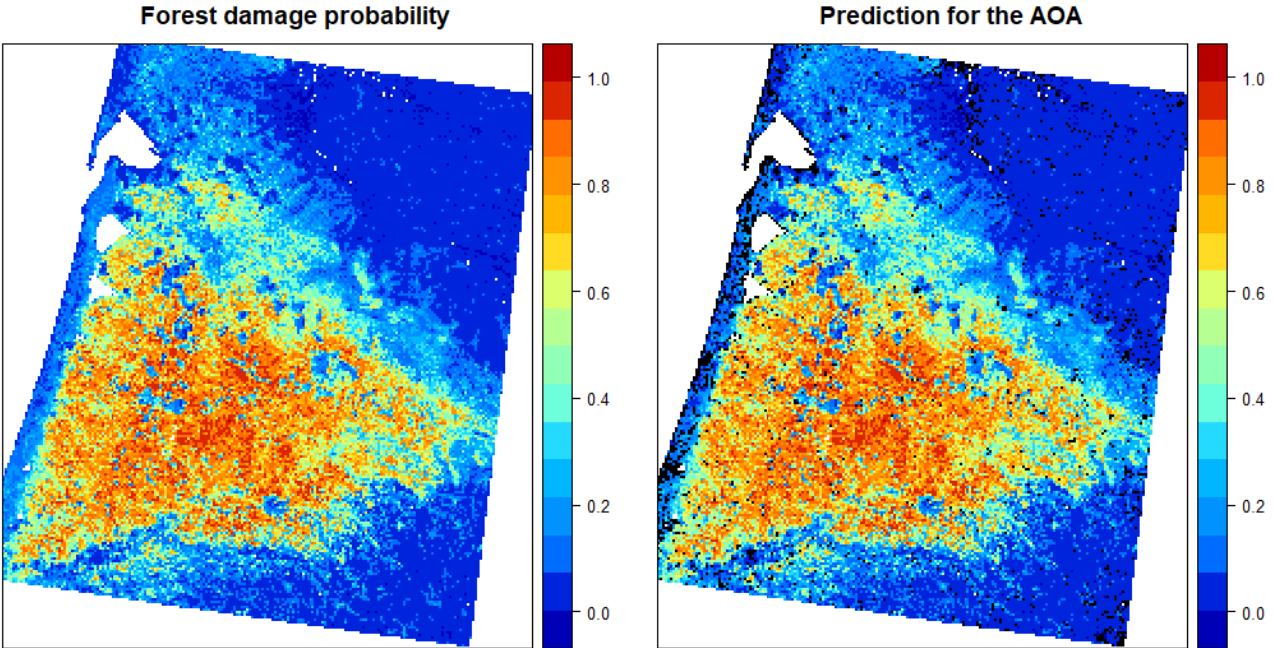
Figure 6. Map of forest damage probability and prediction of the Area of Applicability (AOA). Areas outside of the AOA are shown in black.